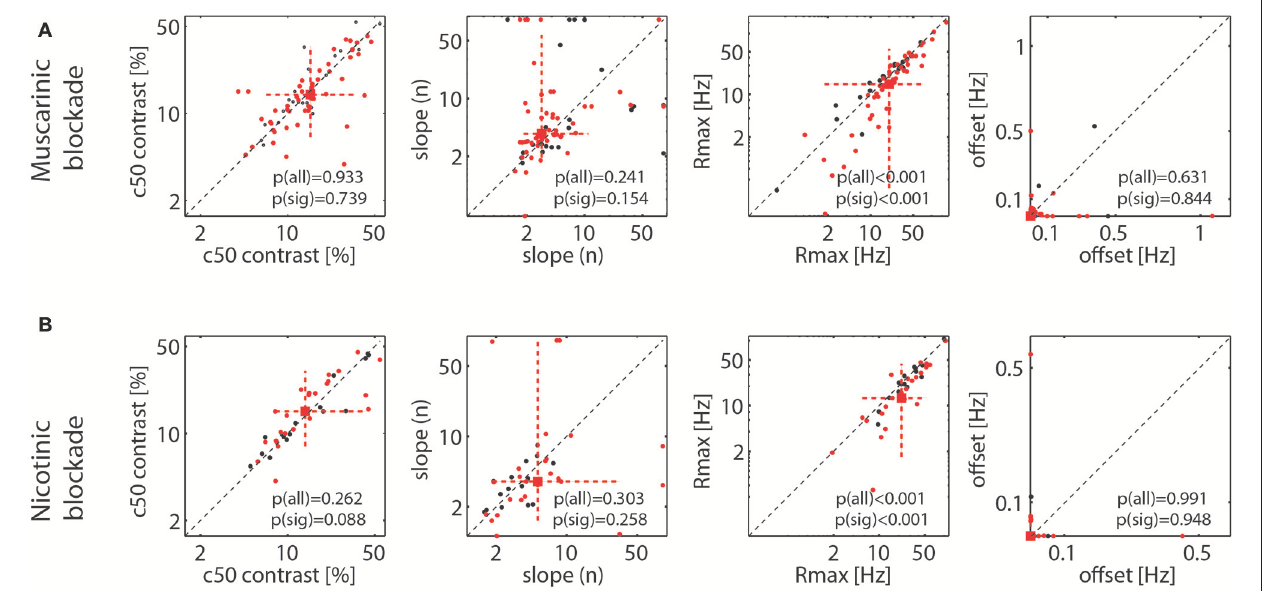
FIGURE 5 | Effect of muscarinic and nicotinic receptor blockade on parameter values of the fitted contrast response function (NAKA-Rushton) for the control and the drug applied conditions. (A) Effect of muscarinic receptor blockade on the contrast at the half maximal response, (c50), the slope of the function (n), the maximal response (Rmax), and the response offset (estimated spontaneous activity). (B) Same as in (A) , but for nicotinic receptor blockade. Black symbols show the fitted parameter values for all recorded cells, red symbols for cells where drug application had a significant effect on their firing rate. Red square symbol shows the median of the parameter estimate for cells significantly affected by drug application, dashed red lines show 10 and 90% percentiles. P -values indicate whether parameter estimates differ significantly between control and drug applied conditions when all cells were taken into account [p(all)] and when only cells significantly affected by the drug application were taken into account